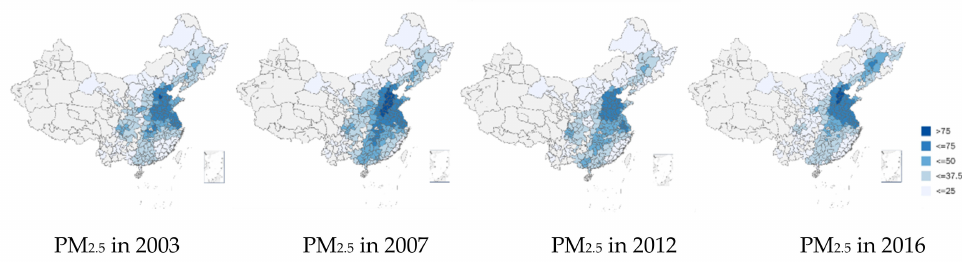
Figure A1. Chinese urban PM 2.5 concentration in different